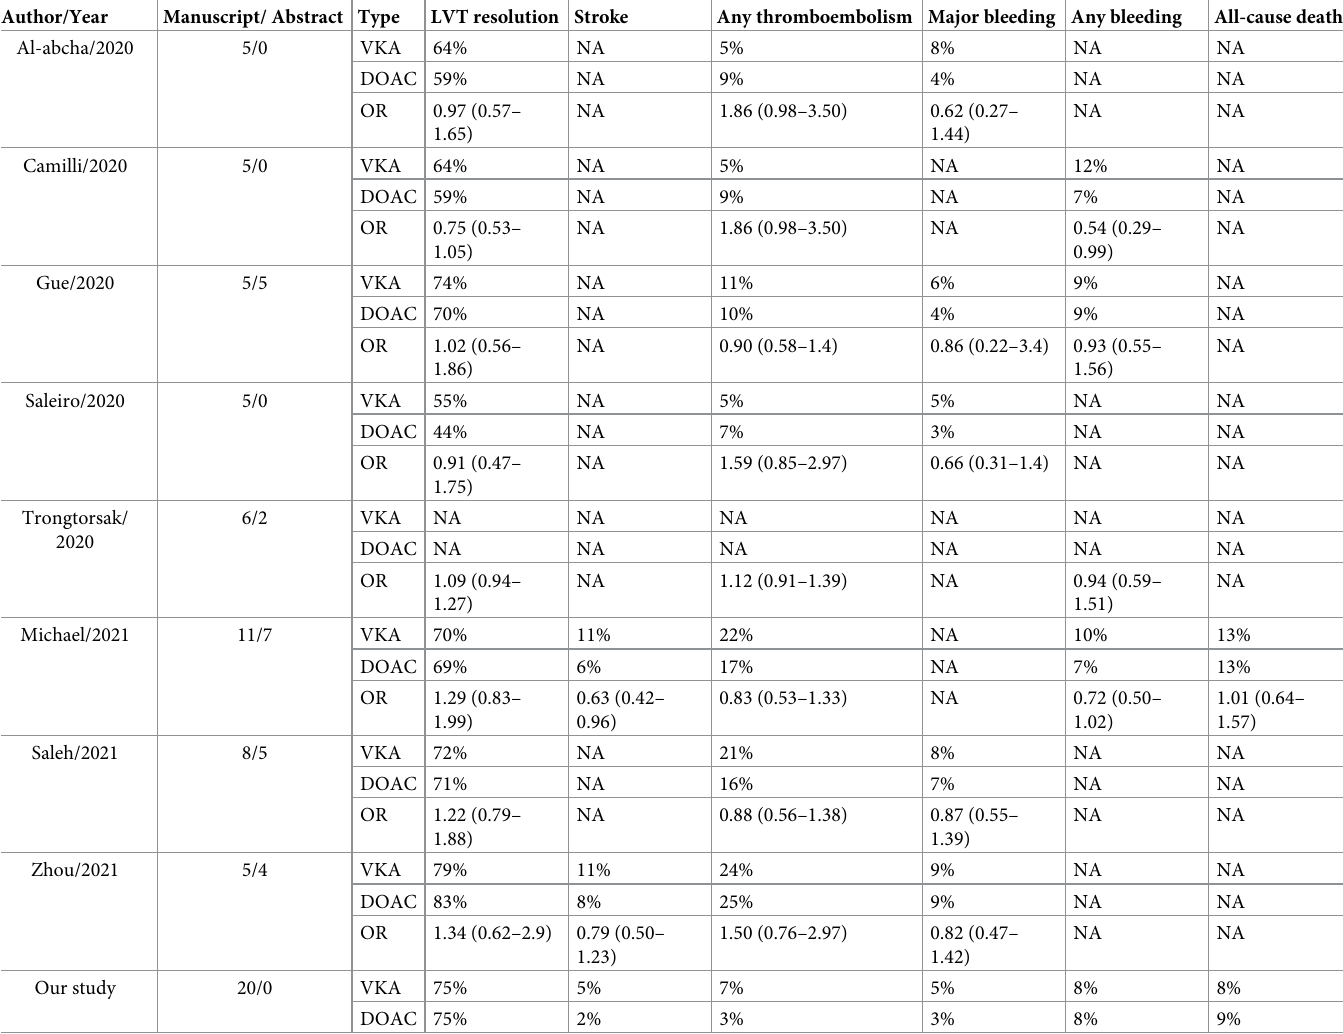
Table 2. Main findings from previous meta-analyses and the current